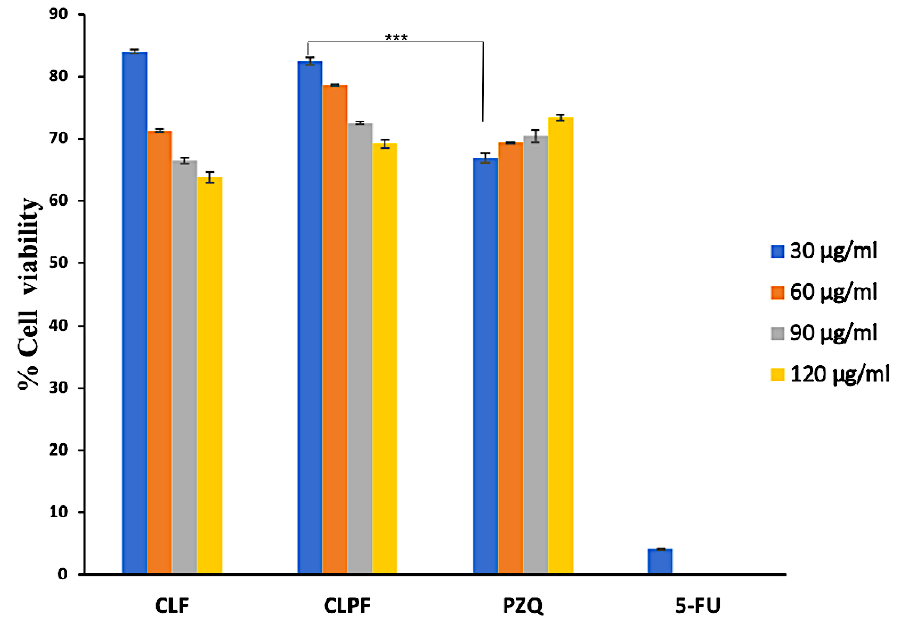
Figure 12. MTT assay measurement of the viability of RAW 264.7 murine macrophage cells after 72h treatment with free PZQ, with the formulated unloaded and PZQ-loaded SLNs at different concentrations (Data represent n = 3, mean ± SD; *** indicates p -value ≤ 0.0001 when compared to the same concentration of PZQ. CLF: Compritol-Lecithin-F127; CLPF: Compritol-Lecithin-PZQ-F127; PZQ: Praziquantel; 5-FU: 5-fluorouracil (10 µg/mL)).